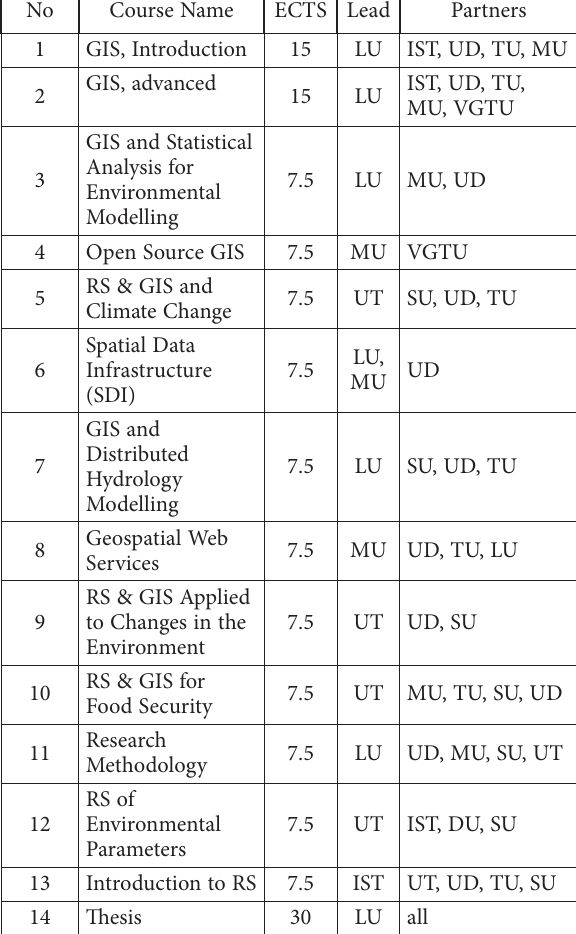
Table 1. List of courses and lead/partners, to be developed in GeoNetC